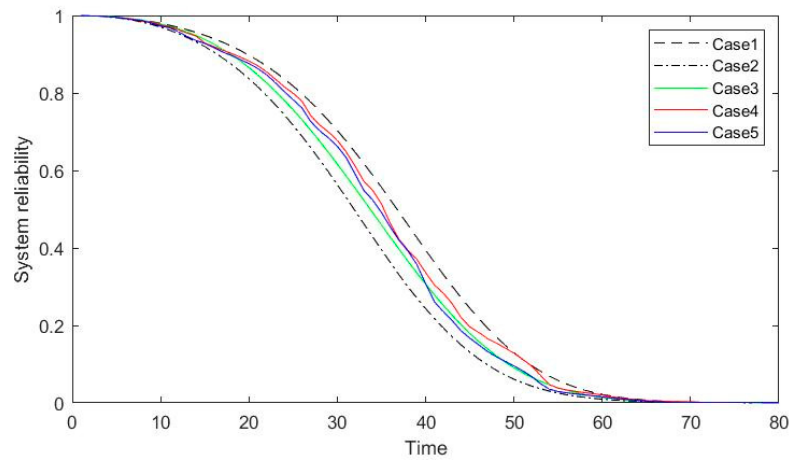
Figure 11. Comparison of the system reliability inference results.